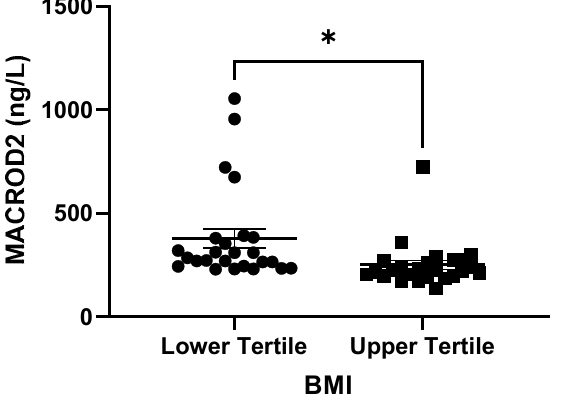
Figure 3. MACROD2 protein levels in serum. Values reflect MACROD2 protein levels (ng/L) in the subjects with the lowest MACROD2 DMR levels of the lower BMI tertile (Lower tertile; n = 36) and the highest MACROD2 DMR of the upper BMI tertile (Upper tertile; n = 37). t-test * p < 0.05 *. Interestingly, MACROD2 protein levels in the serum were negatively associated with BMI (Figure 4A) and positively correlated with Ruminococcus abundance (Figure